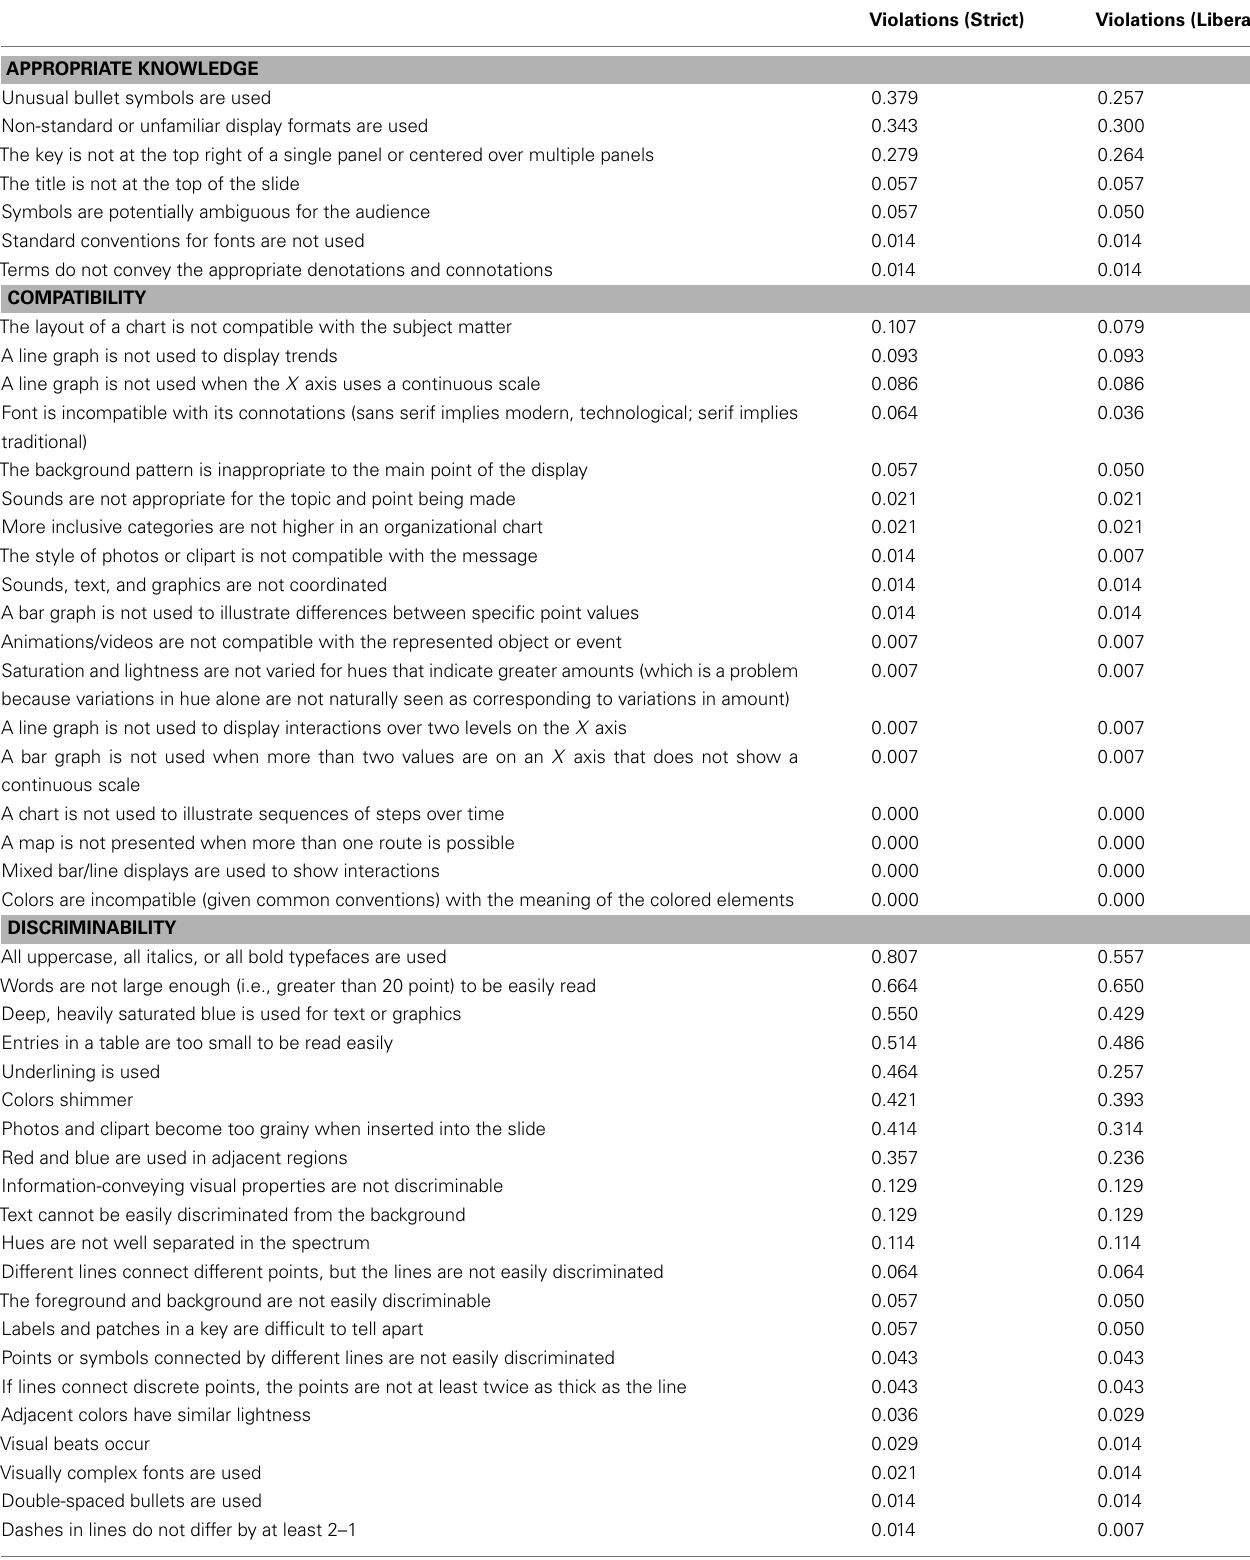
Table 1 | List of rules for each principle and the proportion of presentations violating each rule (according to strict and liberal criteria) for Study